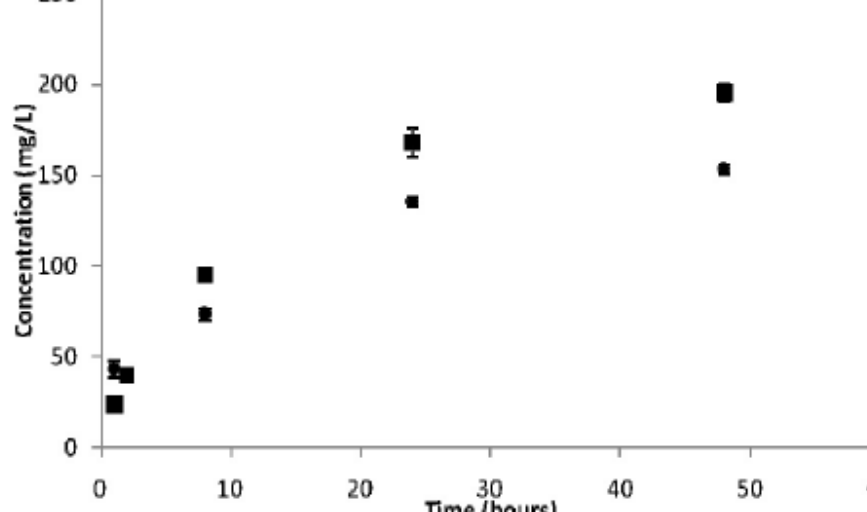
FIGURE 2 - Release of silver sulfadiazine from chitosan gel (circle) and commercially available cream (square). n=3. Error bar: standard deviation. No difference was observed comparing the two formulations (p>0.05)